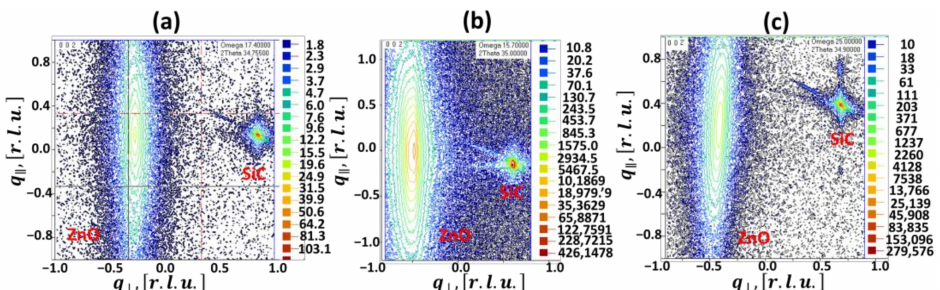
Figure 2. X-ray reciprocal space maps (RSMs) around the (002) reflection measured for ZnO films grown on SiC substrates with different off-cut angles: 0 ◦ ( a ), 2 ◦ ( b ), and 8 ◦ ( c ), respectively. Note: A 2 ◦ off-axis SiC substrate is chosen as a representative of SiC with low off-axis orientation, while 8 ◦ off-axis SiC is regarded as a highly misoriented substrate. [r.l.u.] is reciprocal lattice units. Small spots correspond to SiC substrates. q ⊥ is the path in the q -space for the 2 θ - ω scan, whereas q (cid:107) is the path in the q -space for rocking curve